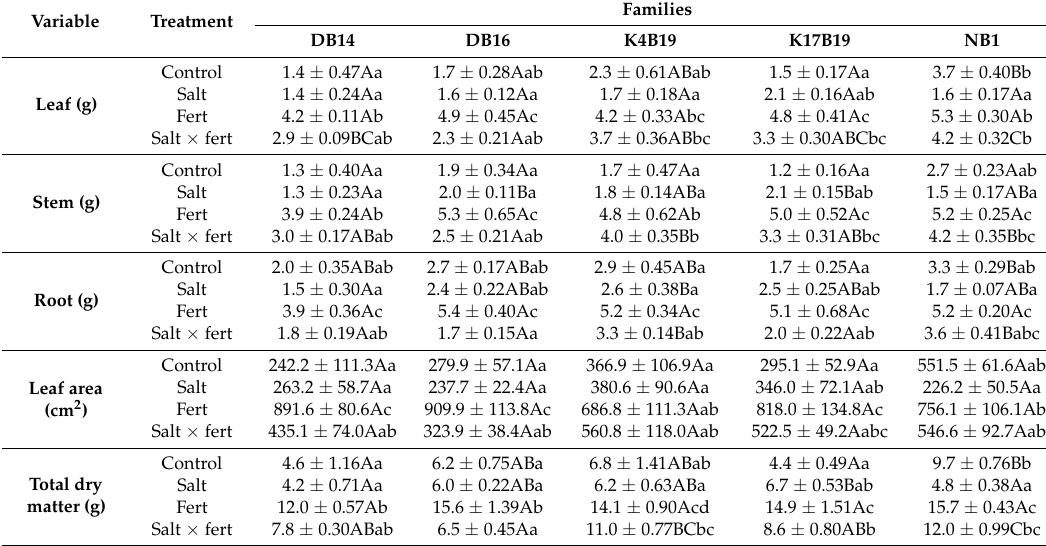
Table 4. The effect of salt and fertilizer treatments on growth parameters of Senegalia Senegal families.